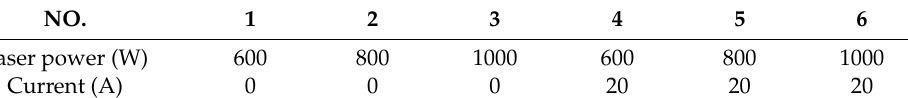
Table 2. Test parameters for LW and HLAW.